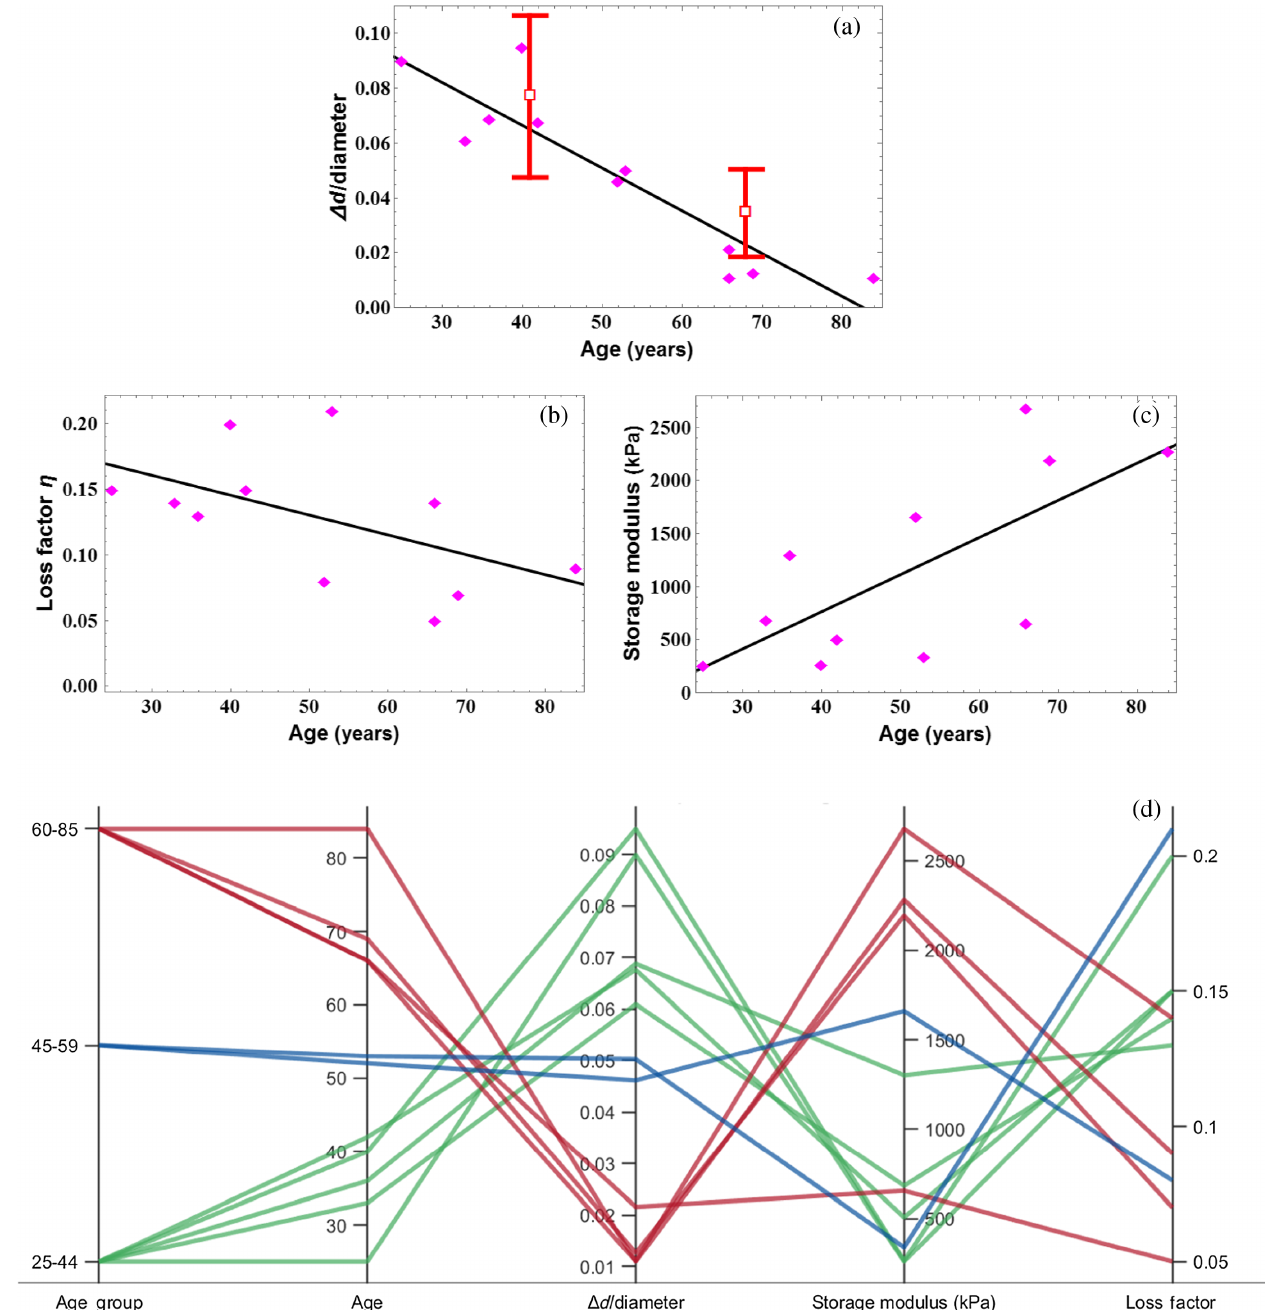
FIG. 6. Correlation for cyclic diameter change and viscoelastic parameters with age at 60 bpm, for the eleven donors: (a) maximum diameter change at 60 bpm pulse rate normalized with respect to the diameter ( Δ d= diameter, experimental points diamond) with linear regression ( 0 . 12889 − 0 . 00156 A, A ¼ age (years); p-value ¼ 0 . 000013 ; Pearson ’ s R ¼ − 0 . 912 ). Data obtained as the average of diameter changes at the proximal and distal extremities of thoracic descending aortas from in vivo CT images from literature is reported for comparison [7]; average values and standard deviations for two age groups ( 41 (cid:1) 7 years; 68 (cid:1) 6 years) of seven individuals each are given (two red error bars); (b) loss factor with linear regression ( 0 . 20602 − 0 . 00151 A, A ¼ age (years); p-value ¼ 0 . 0915 ; Pearson ’ s R ¼ − 0 . 535 ); (c) storage modulus with linear regression ( − 636 . 26 þ 35 . 024 A , A ¼ age (years); p-value ¼ 0 . 0129 ; Pearson ’ s R ¼ 0 . 706 ); (d) parallel coordinate plot demonstrating the relationship between the relative diameter change Δ d= diameter, storage modulus and loss factor with age, for 3 age groups: green line, 25 – 44 years old; blue line, 45 – 59 years old; red line, 60 – 85 years